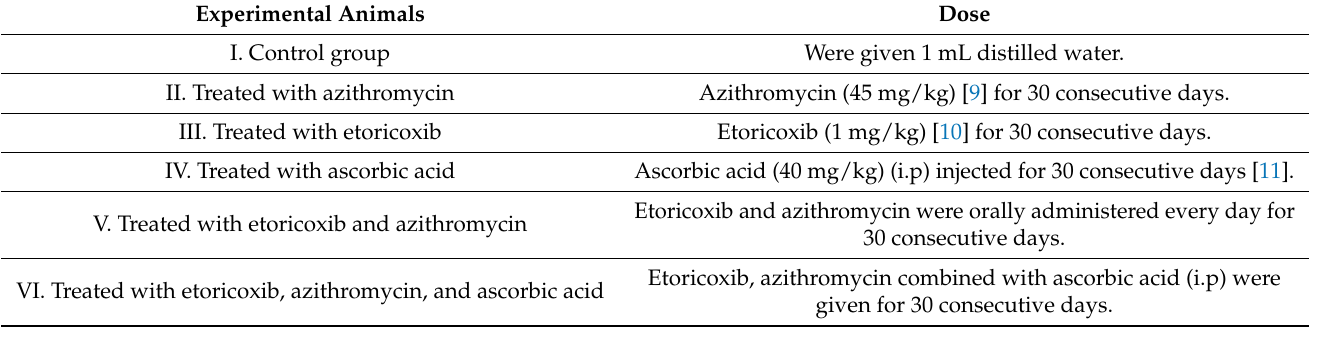
Table 1. Compounds of study.